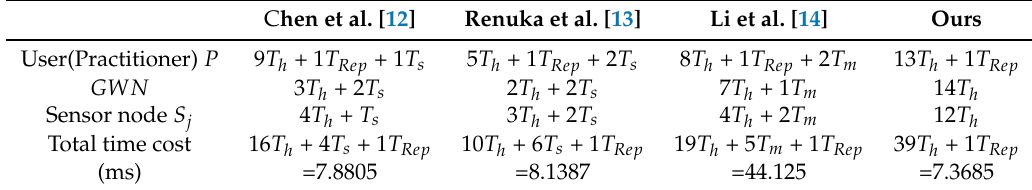
Table 5. Comparison of Computation Costs.